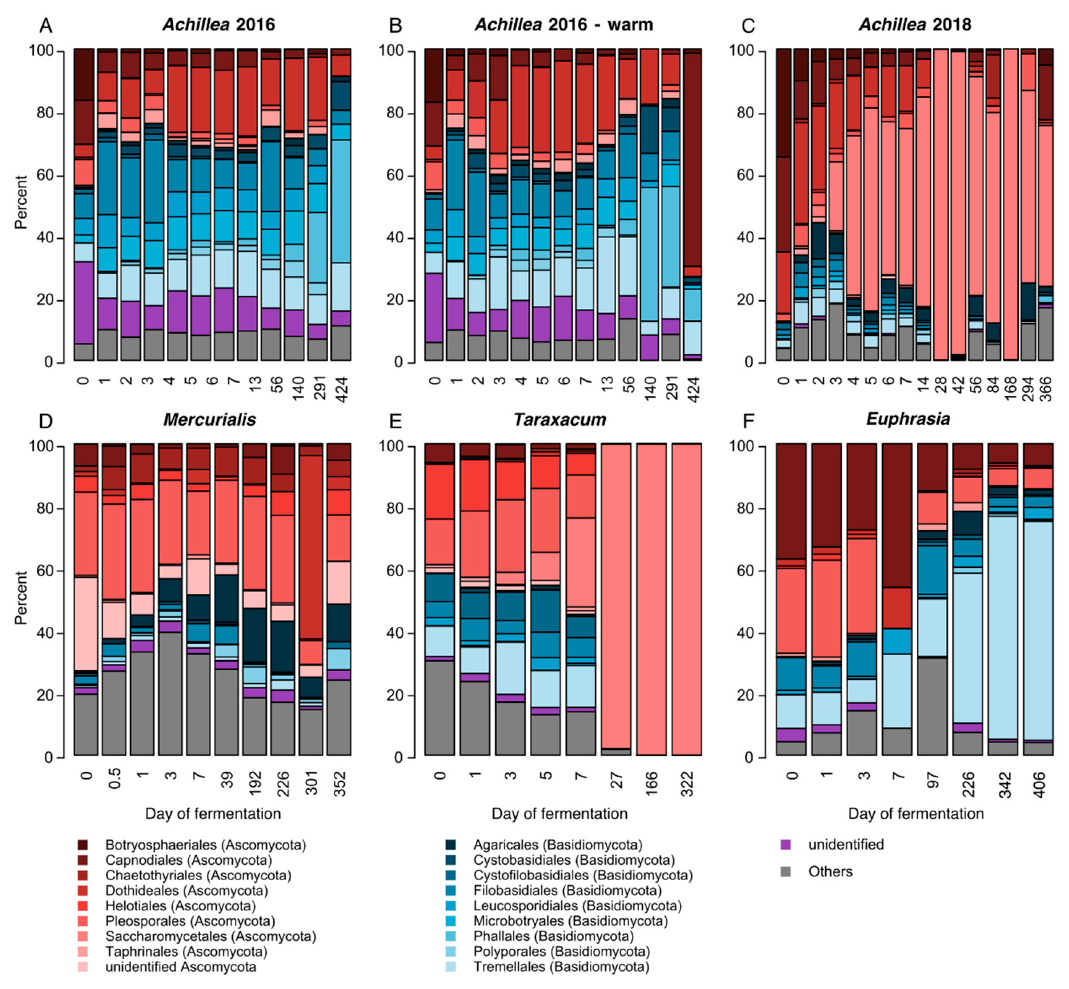
Figure 7. Percentages of the 19 most abundant fungal orders during the fermentation of Achillea ( A – C ), Mercurialis ( D ), Taraxacum ( E ), and Euphrasia ( F ), according to the GHP. Achillea 2016 was also fermented at permanently warm conditions during the initial 7 days ( B